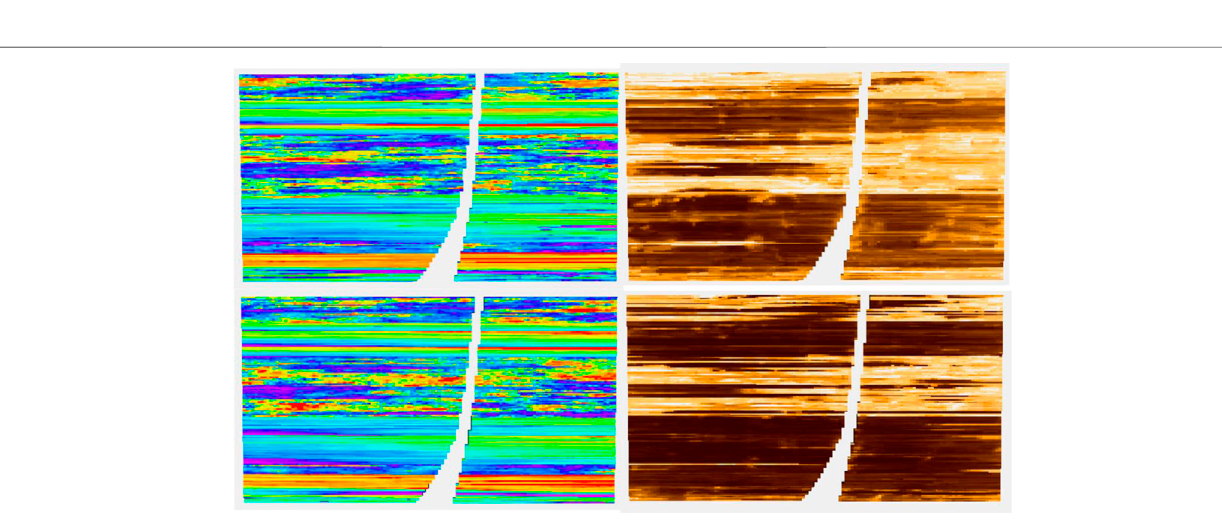
FIGURE 13 | Shoreface layer. Left column, top truth and bottom RAI; middle column, Ember estimates and eight-well case on the top; right column, Ember uncertainty and eight-well case on the top.